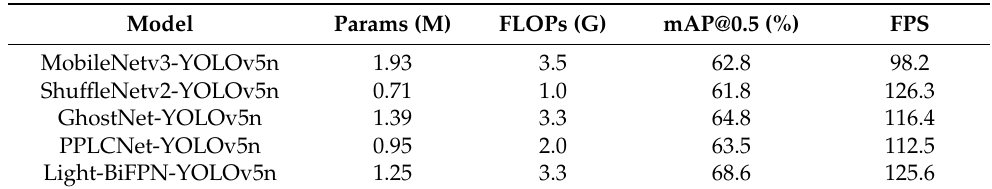
Table 3. The comparative experiments of Light-BiFPN and different state-of-the-art lightweight models.